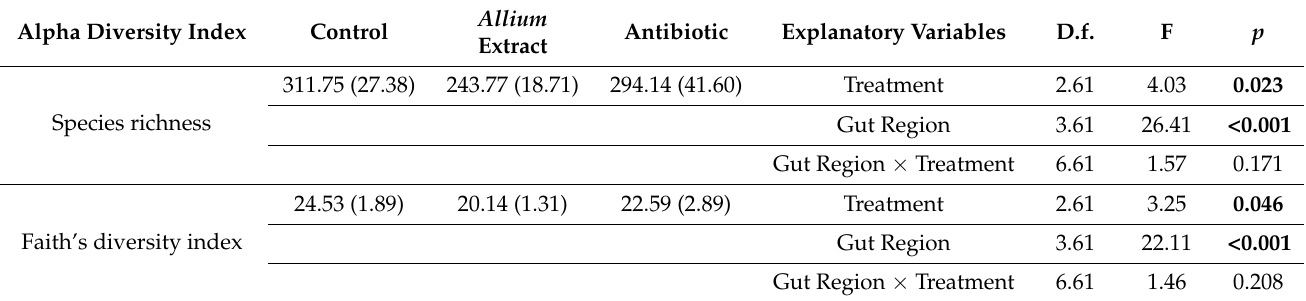
Table 1. General Linear Models exploring the effects of treatment (control, antibiotic and Allium extract) and gut region in the different alpha diversity indices of the bacterial community of weaned piglets. D.f. refers to degree of freedom. The first number is the degree of freedom of the independent variable and the second one for the error term. Significant p -values ( p < 0.05) are shown in bold.